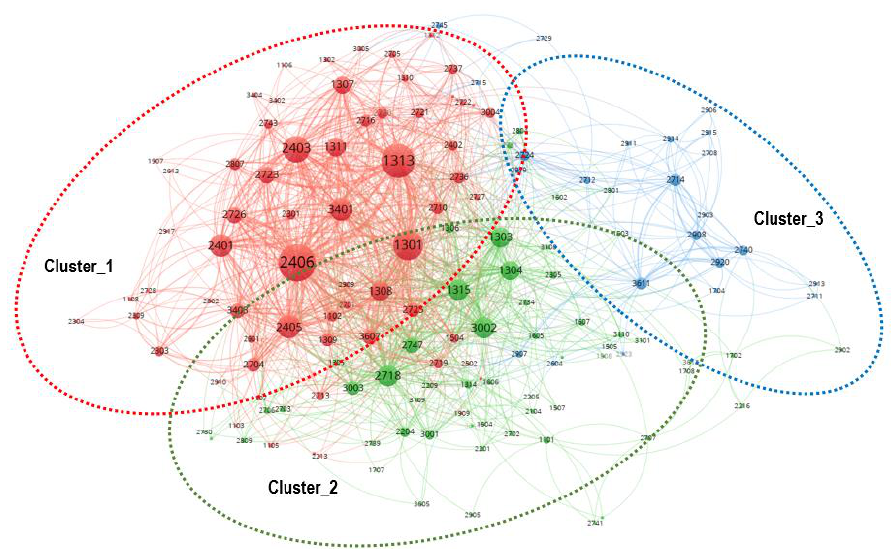
Figure 2. Clusters of R&D fields on coronavirus-related national-funded projects of the US, the EU, and and Japan.